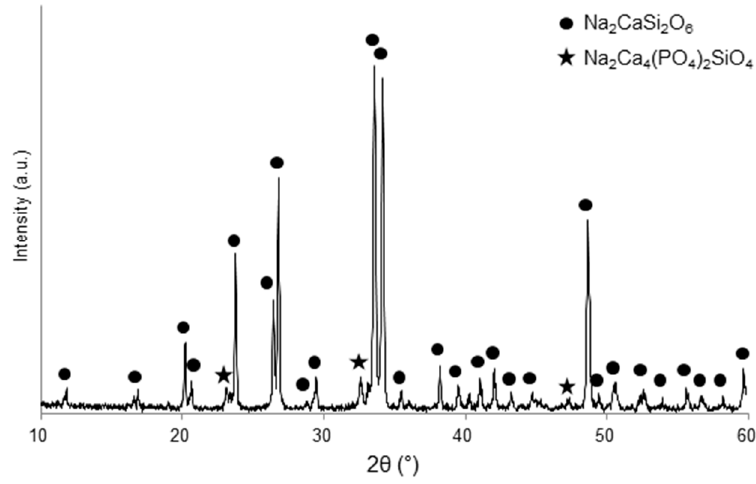
Figure 1. XRD pattern of 45S5-derived glass–ceramic scaffolds.